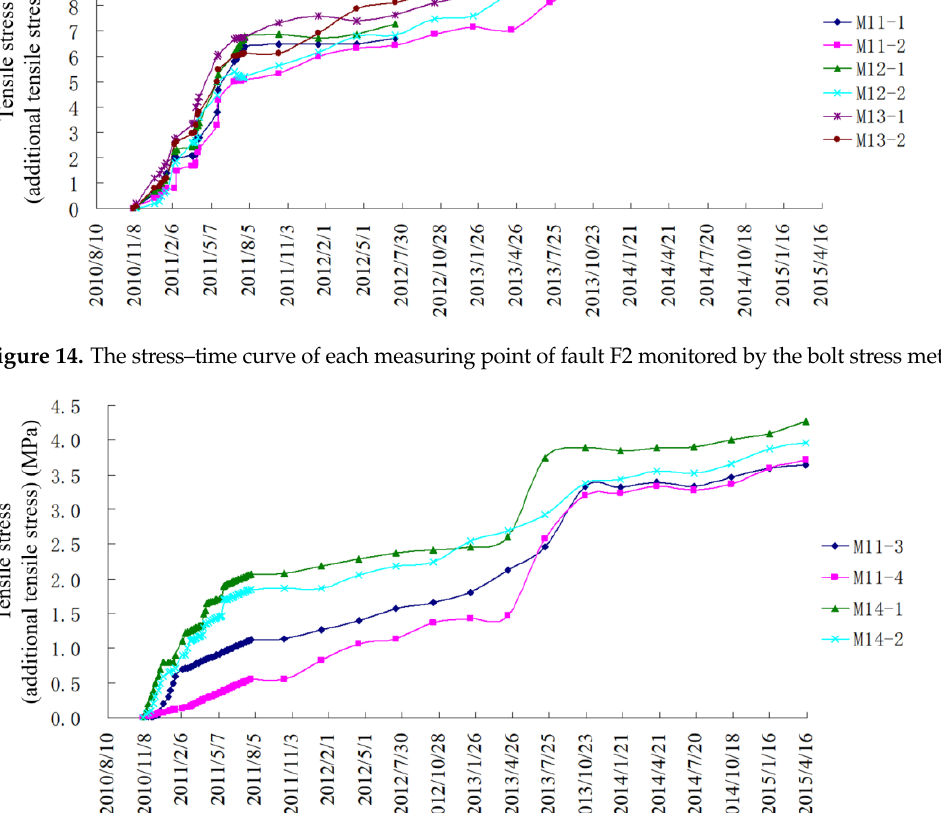
Figure 15. The stress–time curve of each measuring point of fault F3 monitored by the bolt stress meter.